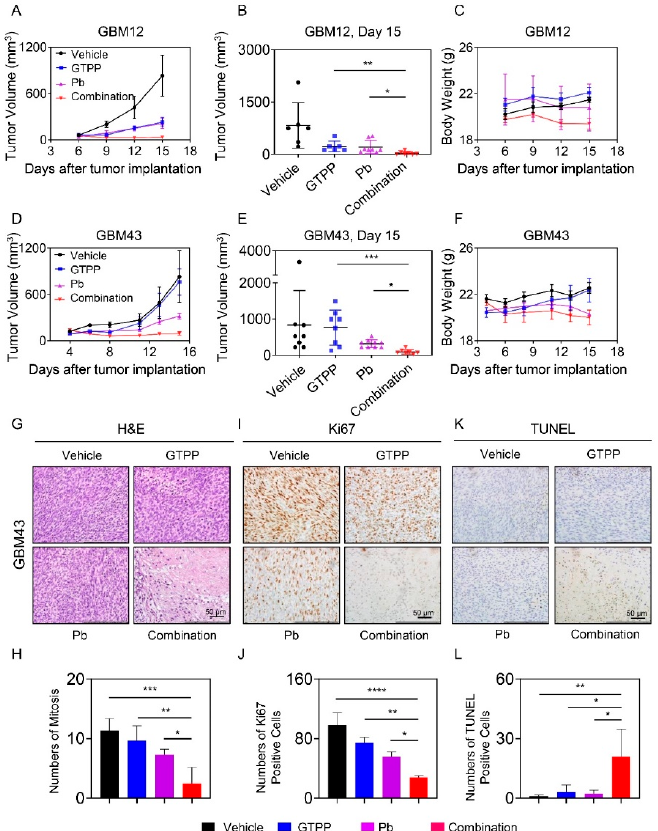
Figure 6. Combined treatment with gamitrinib (GTPP) and HDAC inhibitor, panobinostat, elicits enhanced tumor growth inhibition in vivo. ( A ) Patient-derived xenograft tumors, GBM12 cells were